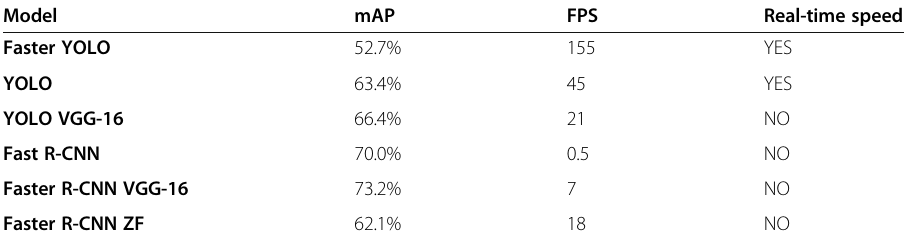
Table 2 Speed and performances for trained model with the 2007 and 2012 VOC datasets Model